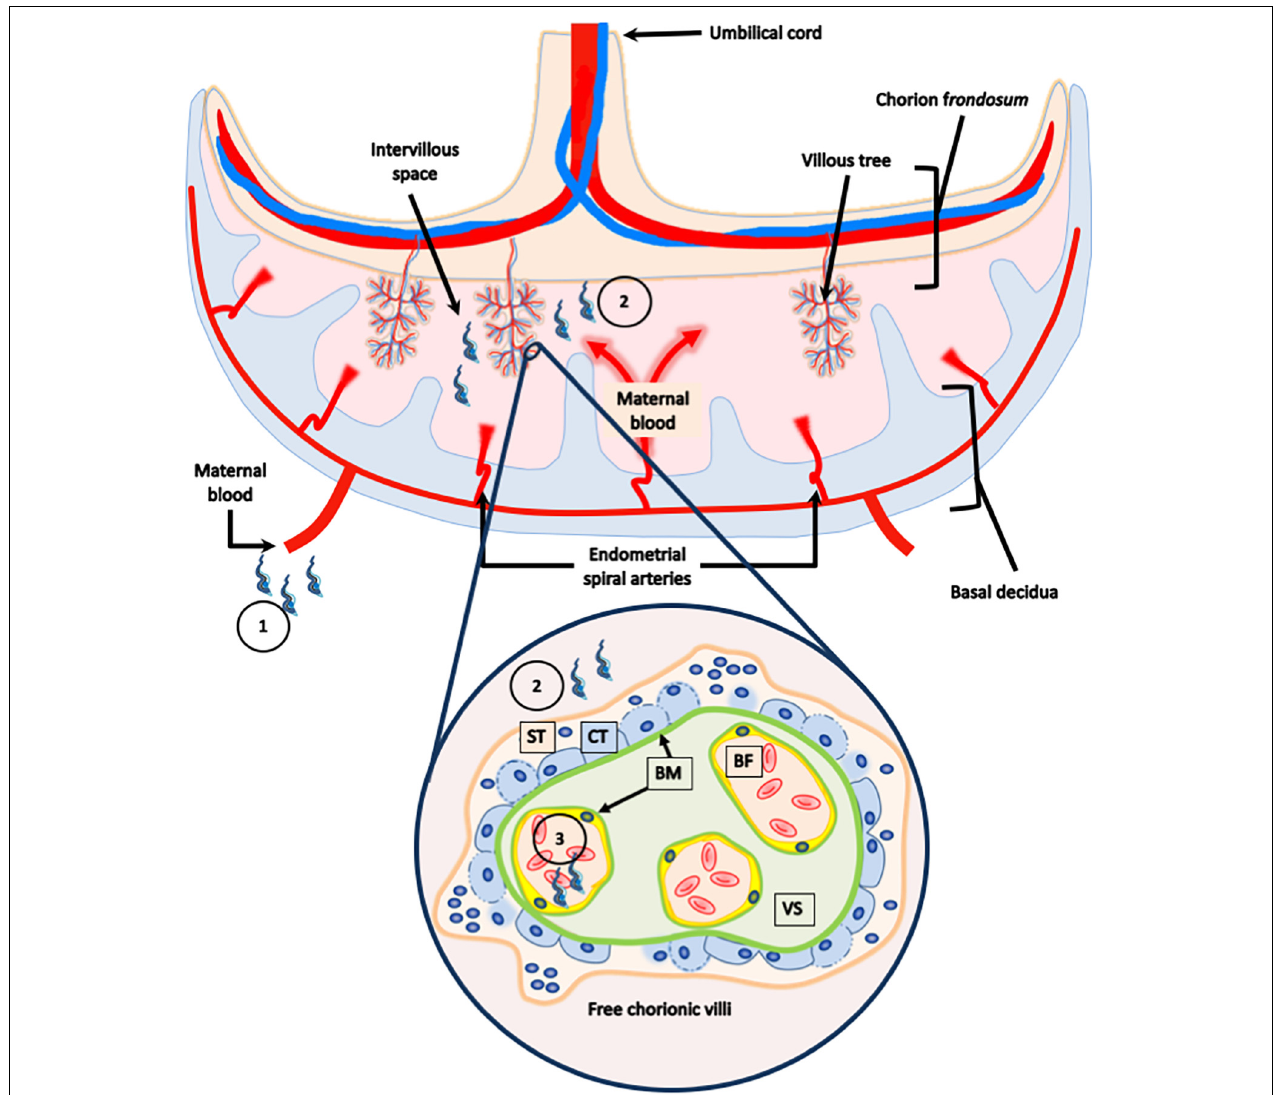
FIGURE 1 | Human placental barrier. The human placenta is classified as a hemochorial chorioallantoic placenta. The placenta is composed of a fetal portion, developed from the chorion frondosum, and a maternal portion, or basal decidua, which originates from the endometrium. The functional units, were the placental barrier is located, are the free-floating chorionic villi formed by the trophoblast, and the villous stroma. Maternal blood surrounds and contacts the trophoblast in the placental intervillous space. The trophoblast is a bi-stratified covering epithelium composed of a superficial non-proliferative syncytiotrophoblast (ST), and a proliferate germinal layer, the cytotrophoblast (CT). The trophoblast is connected to and separated from the villous stroma (VS), the fetal connective tissue, and by a basal lamina. The parasite present in the maternal blood (1), that comes in contact with the trophoblast in the intervillous space (2), must cross the placental barrier in order to reach the fetal capillaries (3), and infect the fetus during transplacental